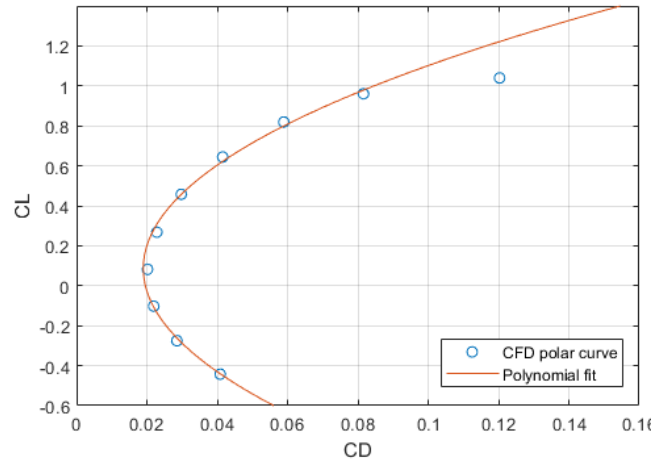
Figure 14. Tail-sitter polar curve: CFD vs. polynomial fit.